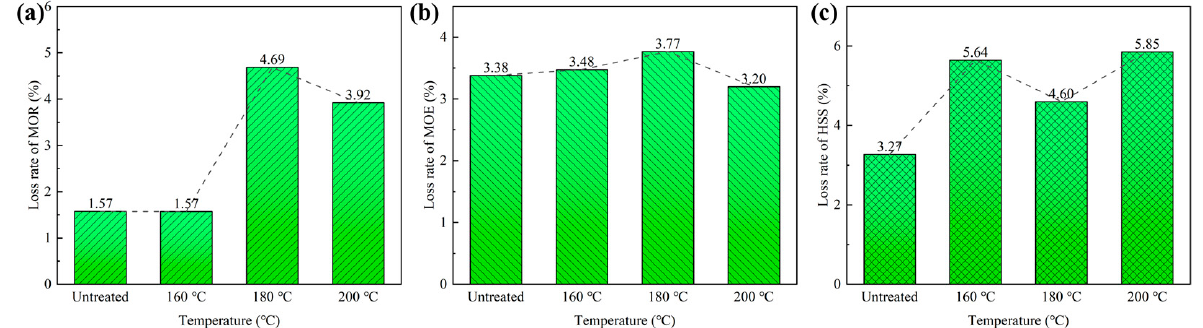
Figure 4. Loss rates of ( a ) MOR, ( b ) MOE and ( c ) HSS of bamboo scrimbers after the accelerated aging test.